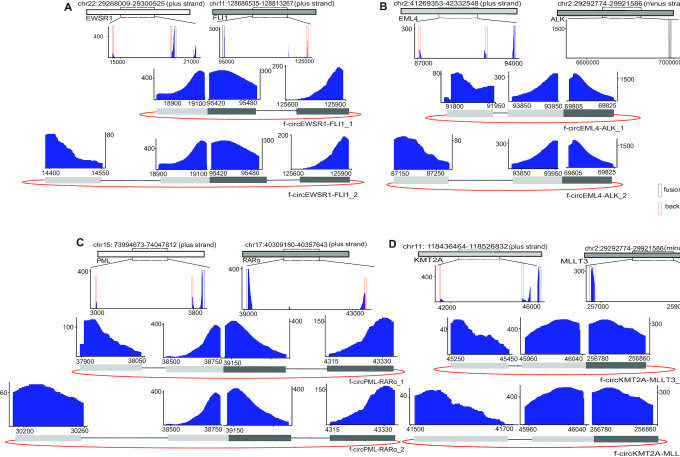
Visualization of f-circRNAs. The structure of fusion circular RNAs (n = 2 for each fusion gene) that were identified in the paired-end sample analysis with 100× coverage and a read length of 100 bp (Fig. 5A) is visualized for f-circEWSR1-FLI1 (A), f-circEML4-ALK (B), f-circPML-RARα (C), and f-circKMT2A-MLLT3 (D). The distribution of fusion-supporting reads on the fusion region (middle graph) and of f-circRNA-supporting reads on the back-spliced region (lower graph) are depicted.